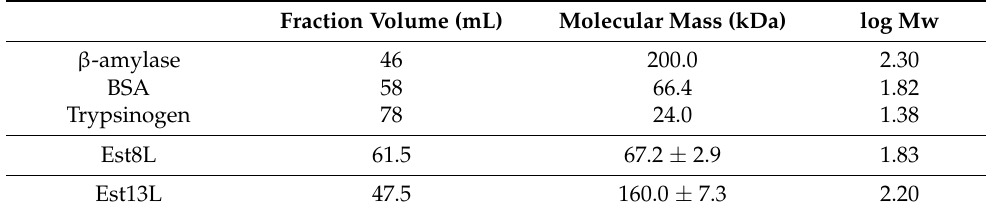
Table 2. Molecular masses of native Est8L and Est13L determined by Sephacryl S-200 HR.